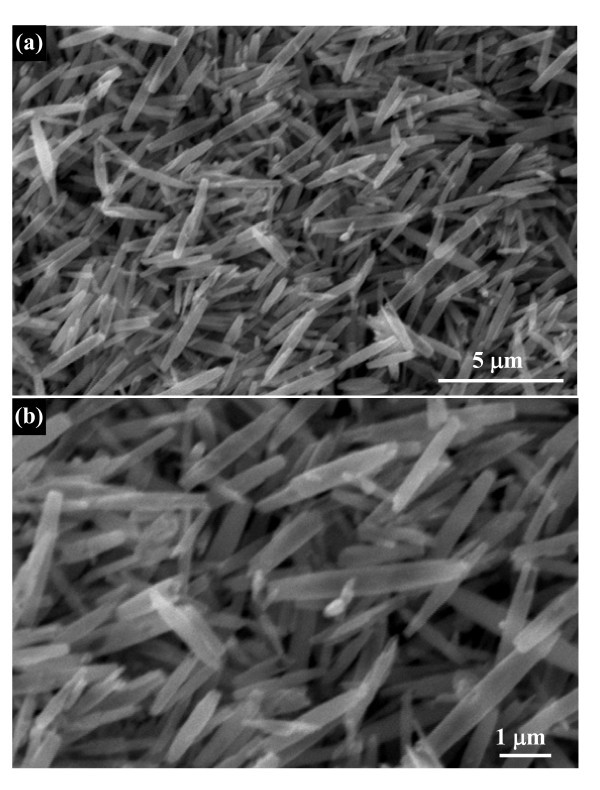
SEM images of single-crystalline nanoporous Nb2O5 nanotubes: (a) low-magnification SEM image; (b) high-magnification SEM image.